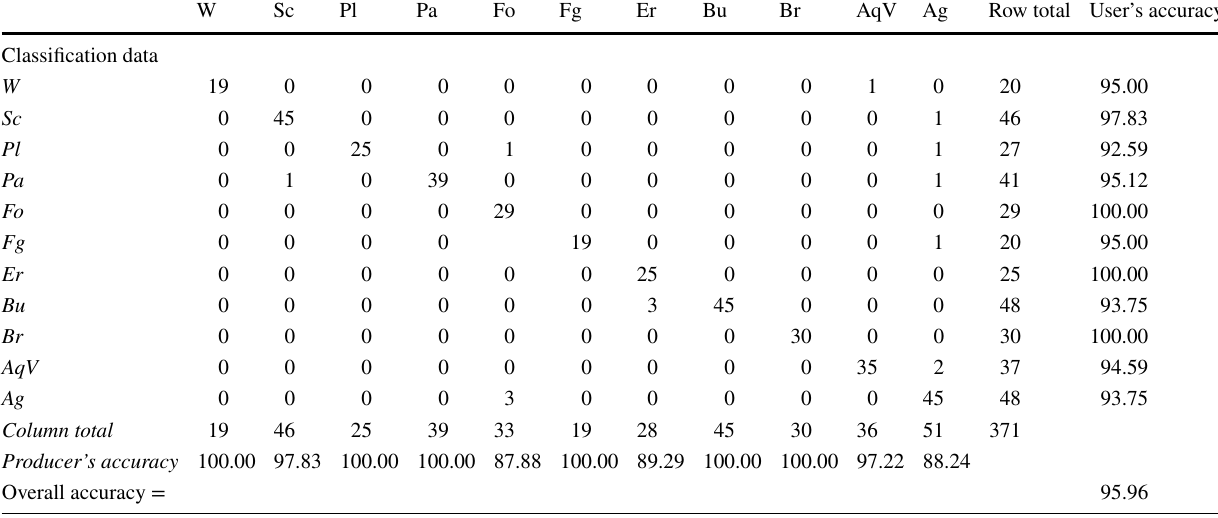
W water, Sc scrub, Pl plantation, Pa pasture, Fo forest, Fg floating garden, Er exposed rock, Bu built-up, Br bare, AqV aquatic vegetation, Ag